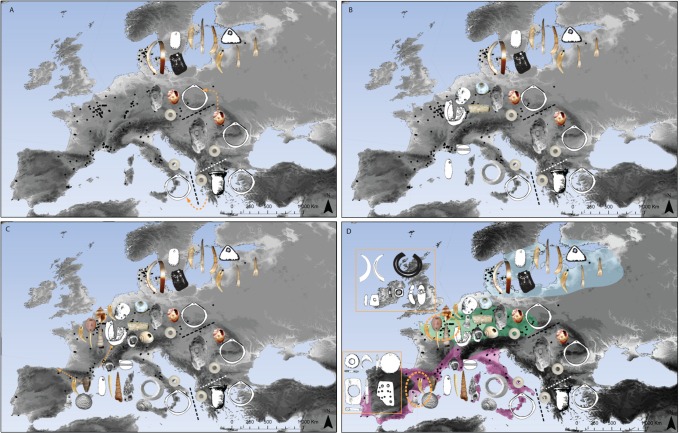
Cartography of the Early Neolithic bead-type configuration.A) Large-scale diffusion of exclusively Neolithic ornament types; B) Diversification of Early Neolithic ornament types; C) Persistence of Mesolithic bead-types in the Neolithic; D) Emergences of new bead types at regional scale. Dotted black lines indicate the major shifts in bead-type associations in South East Europe. Dotted orange ellipses show the two areas where numerous new bead-types were adopted during the end of the Early Neolithic. Color shaded areas indicate the geographic distribution of the MEN (pink), DEN (green) and BEN (blue) archaeological cultures considered in the analysis. Maps were made by S.R. by using ArcGIS 9.3.1 software. Some bead types were redrawn from [64–67].